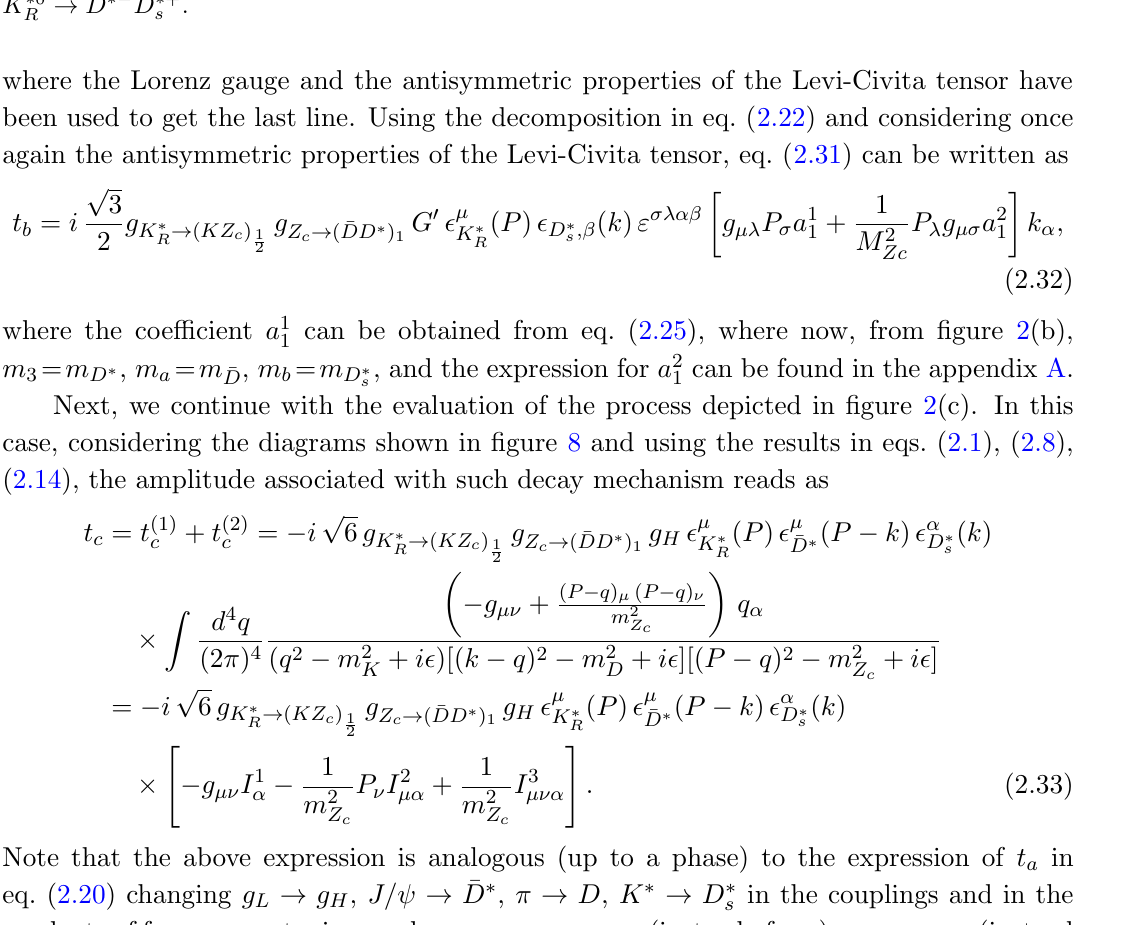
Figure 8 . Contributions associated with the diagram (c) of (cid:12)gure 2 for the decay mechanism K (cid:3) 0 ! D (cid:3)(cid:0) D (cid:3) + s R